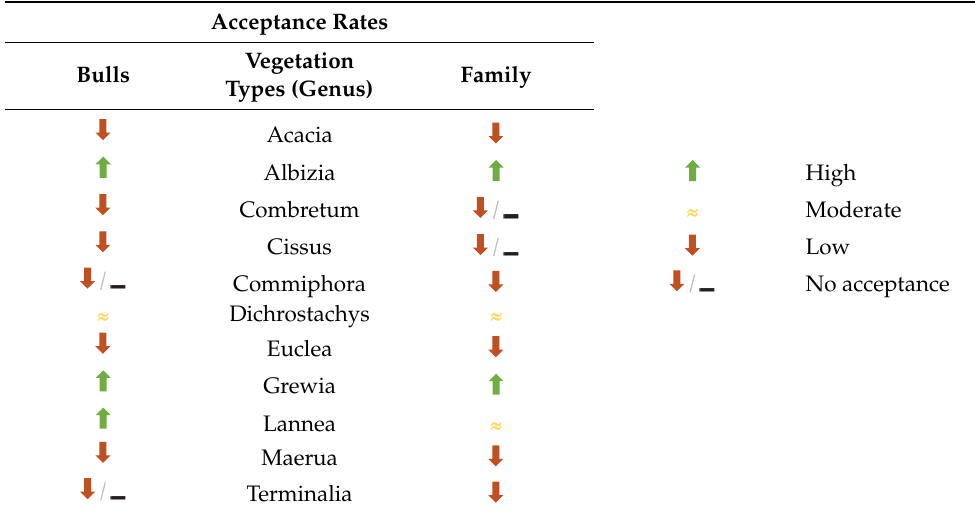
%T= Total RIV of vegetation genus type in a classification class, F= Family, Fe= Females, B= Bulls =High acceptance  =Moderate acceptance =Low acceptance =No acceptance